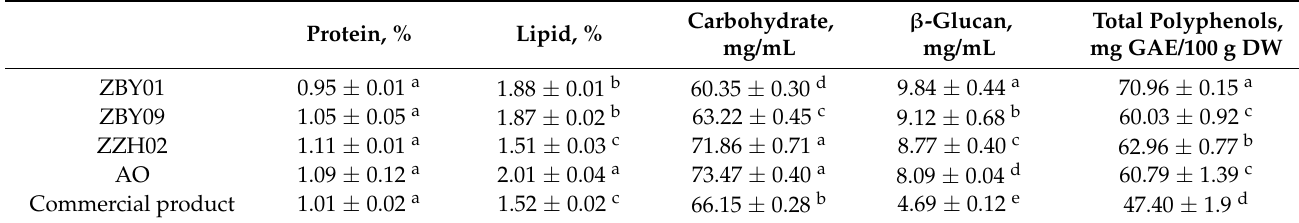
Table 5. Nutritional composition of oat